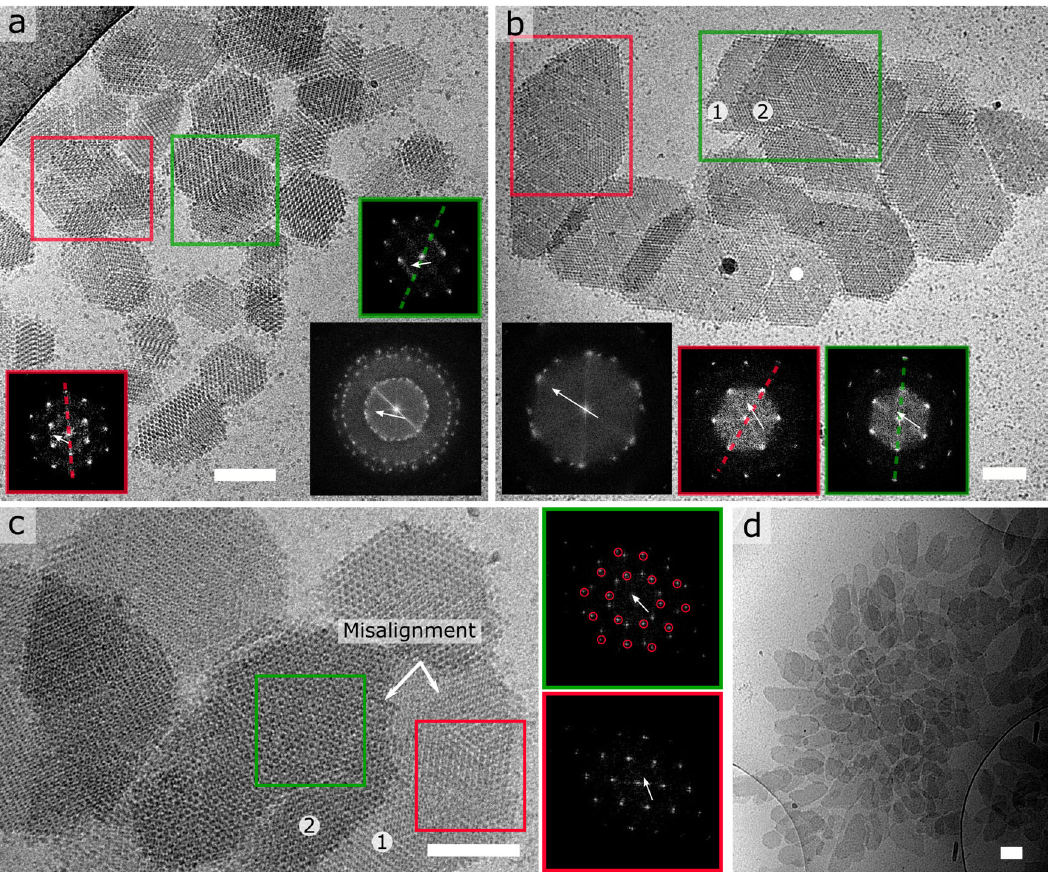
Fig. 3 Lack of inter-crystal alignment in large nanocrystal assemblies. a Poly-crystalline cluster with local hotspots of alignment (see FFT insets), b example of two vertically stacked domains exhibiting registry between their corresponding lattices (blue) but a 26° misalignment with the region enclosed in red, c example of lack of axial alignment between two nanocrystals where the FFT of the interlaced pattern (green) reveals two independent lattices residing at an angle of 25°, d disordered grouping of over 100 nanocrystals. Scalebar is 100 nm. White arrows in the FFT ’ s correspond to a resolution of 6.6